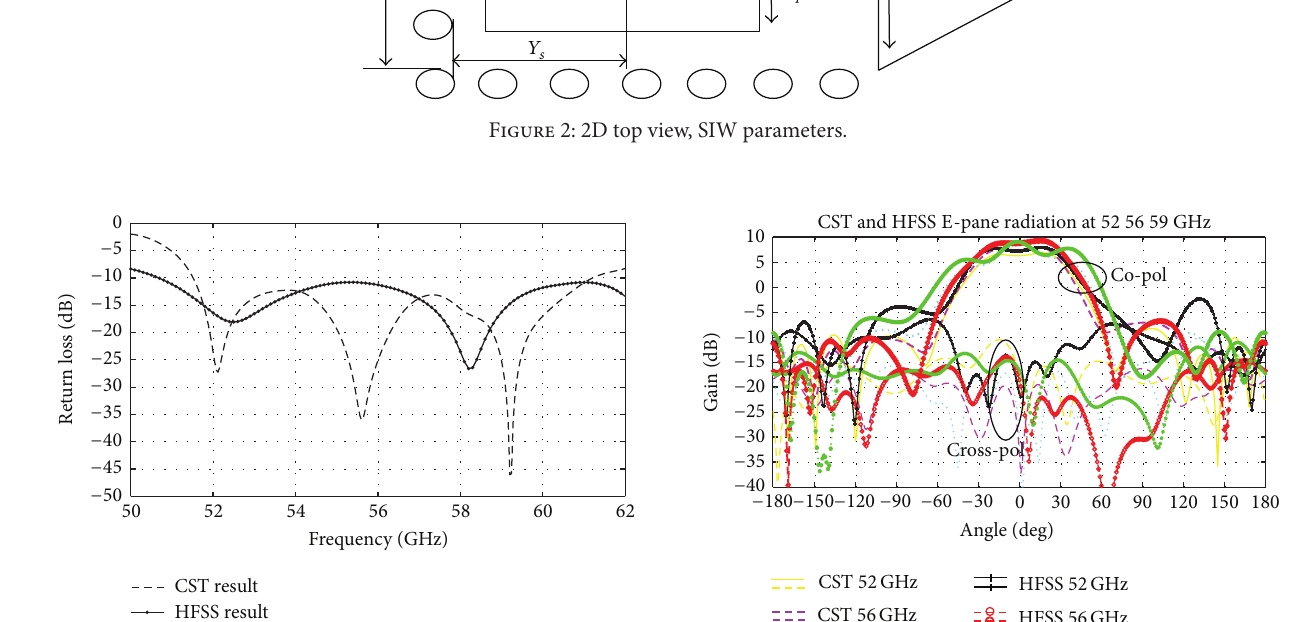
Figure 3: Simulated return loss.